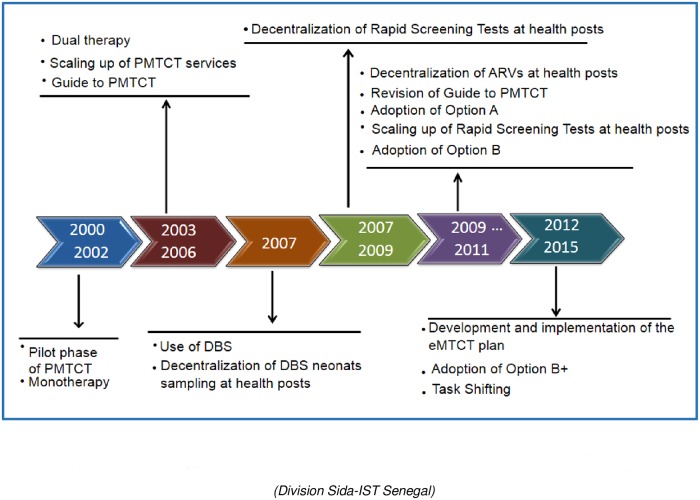
Expansion and improvement in PMTCT interventions in Senegal.(Division Sida-IST Senegal).